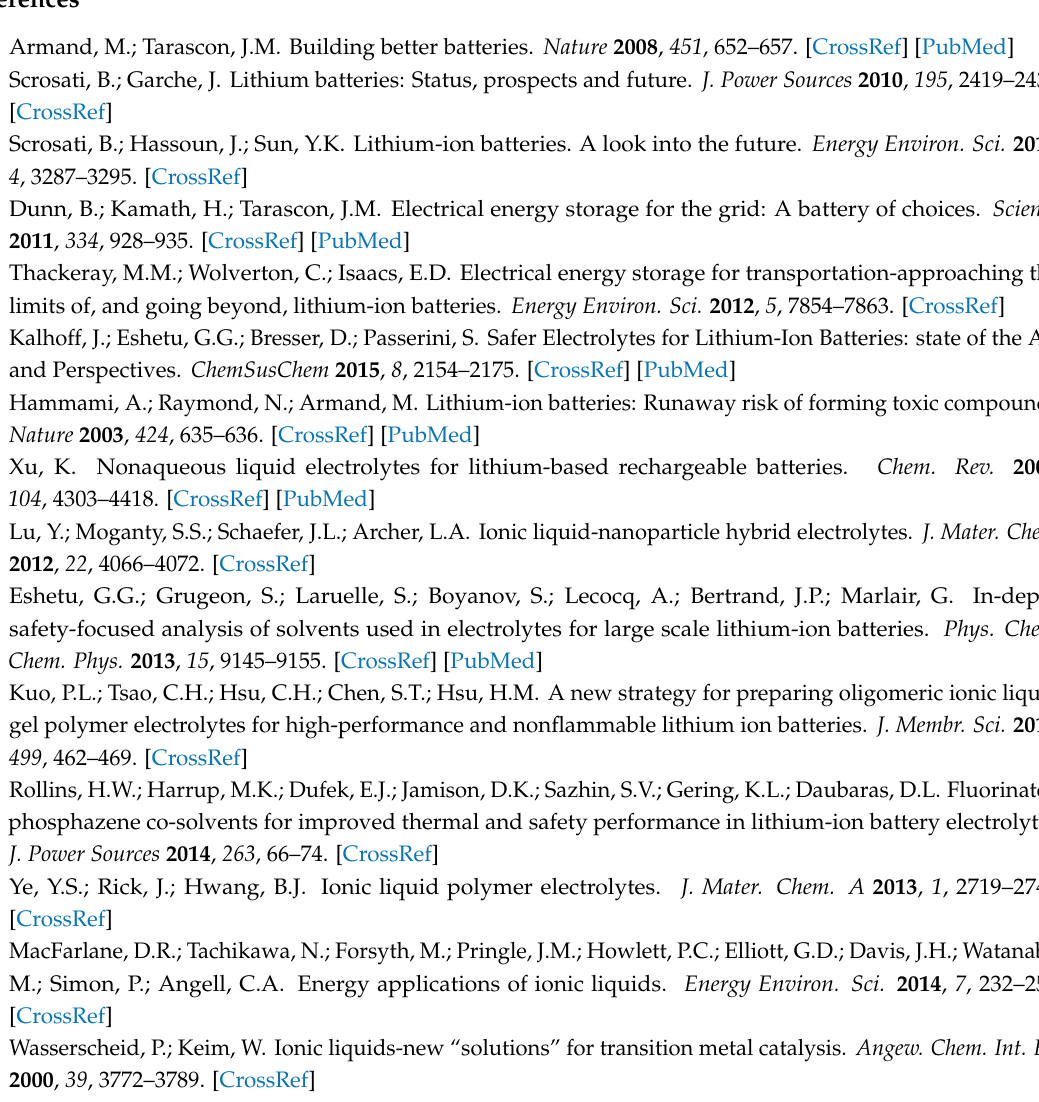
Table S1: Properties of the aqueous dispersion of PVdF-HFP NPs, Table S2: Ionic conductivity